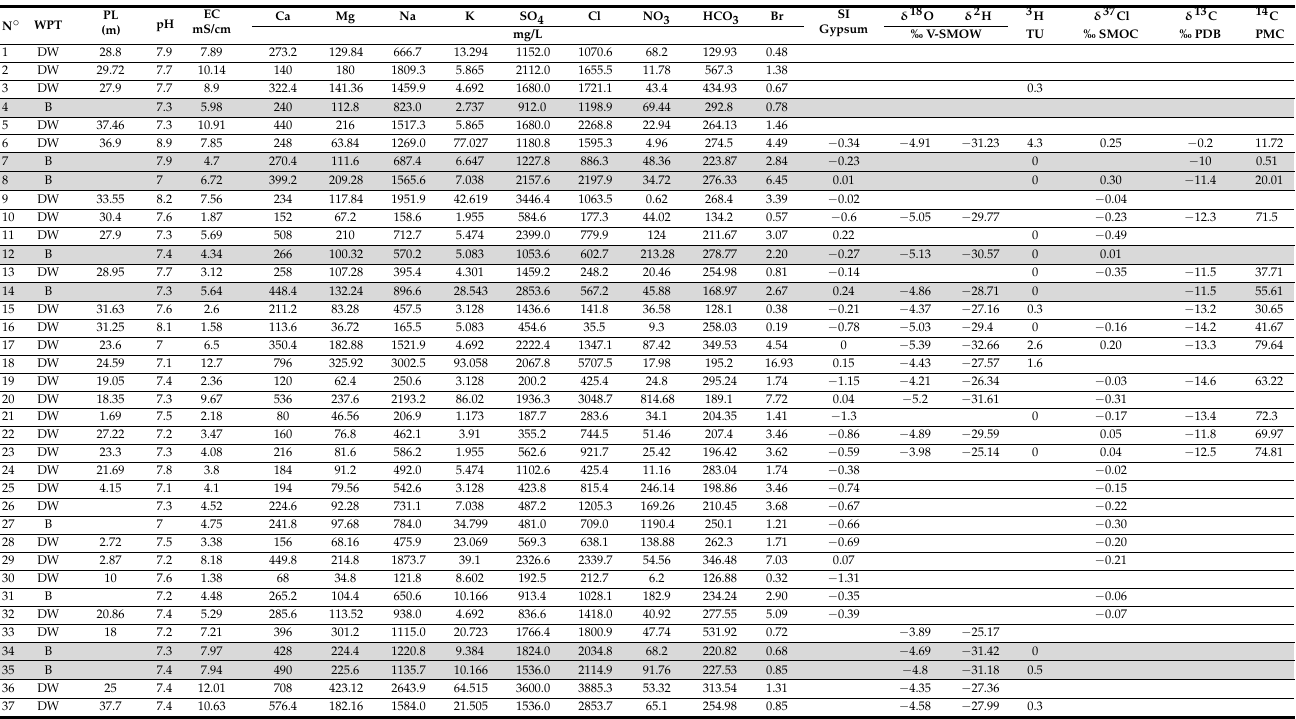
Table 1. Chemical and isotope ( 2 H, 18 O, 13 C, 37 Cl, 3 H and 14 C) data in Oued Laya